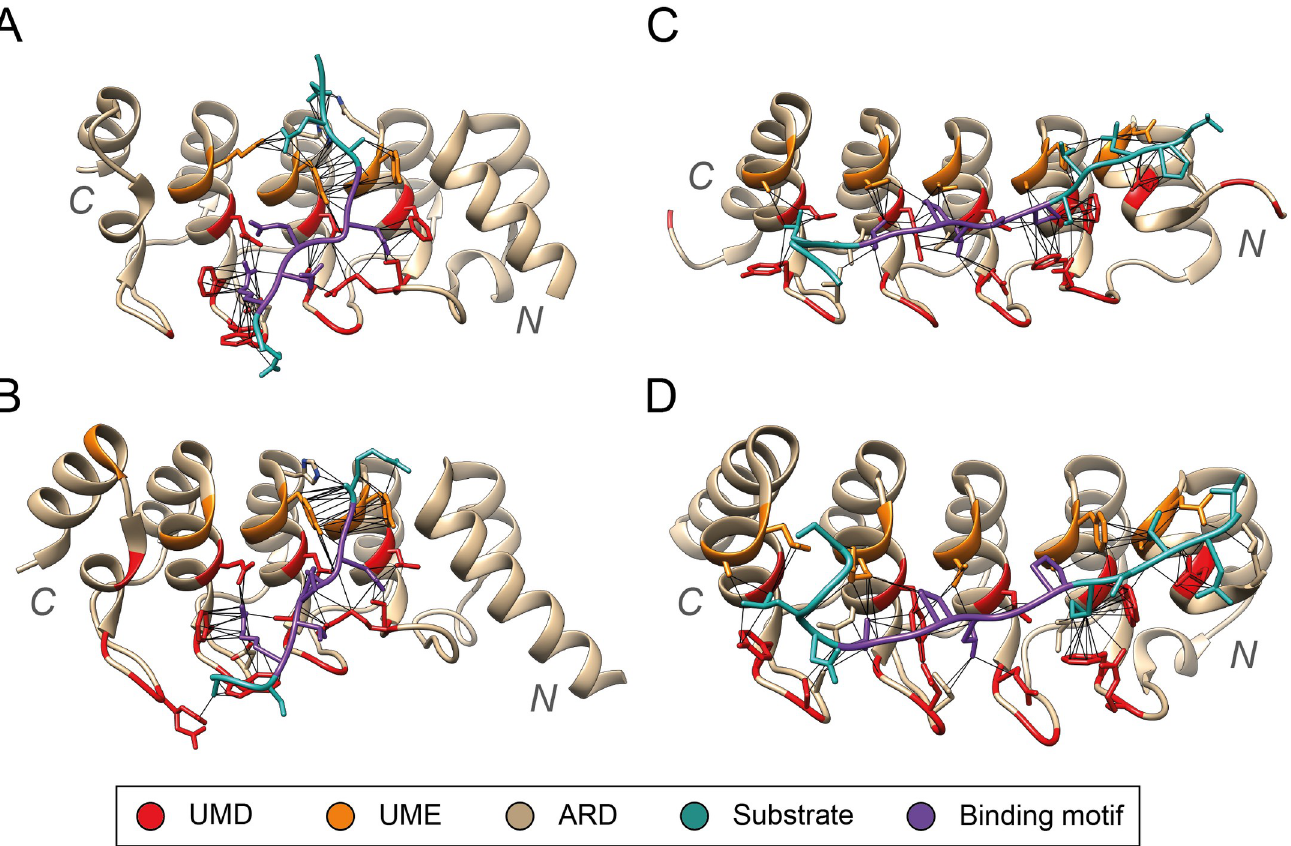
Fig 12. ARDs in complex with substrates. (A) RFXANK and RFX5 (PDB ID: 3V30) [56]; (B) ANRA2 and HDAC4 (3V31); (C) TNKS2 and ARPIN (4Z68) [59]; (D) TNKS1 and USP25 (5GP7) [60]. UMD positions (red) and UMEs 11, 12 (orange) are conserved across proteins that bind similar substrates (dark cyan). For example, these positions are conserved across TNKS2 and TNKS1, which are known to bind substrates with the motif RXXPDG (purple). Similarly, RFXANK and ANRA2, bind substrates with the motif PXLPX[I/L] (purple). Figure obtained with UCSF Chimera